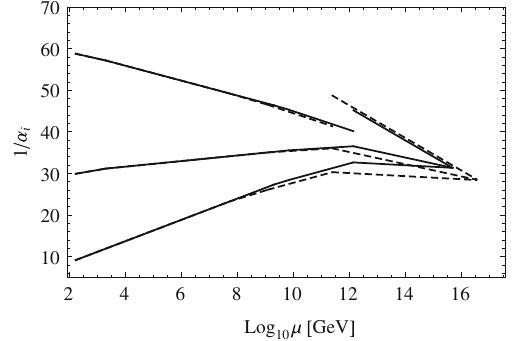
Fig. 2 For m D = 2 TeV and m T = 5 × 10 4 TeV (solid lines) and m T = 2 × 10 6 TeV (dashed lines), the three solid and dashed lines from top to bottom correspond to α 1 , 2 , 3 for μ < M I and α R , L , 4 for M I < μ < M GUT . For m T = 5 × 10 4 ( 2 × 10 6 ) TeV, we find M I (cid:2) 1 . 4 × 10 12 ( 2 . 4 × 10 11 ) GeV and M GUT (cid:2) 4 . 6 × 10 15 ( 3 . 4 × 10 16